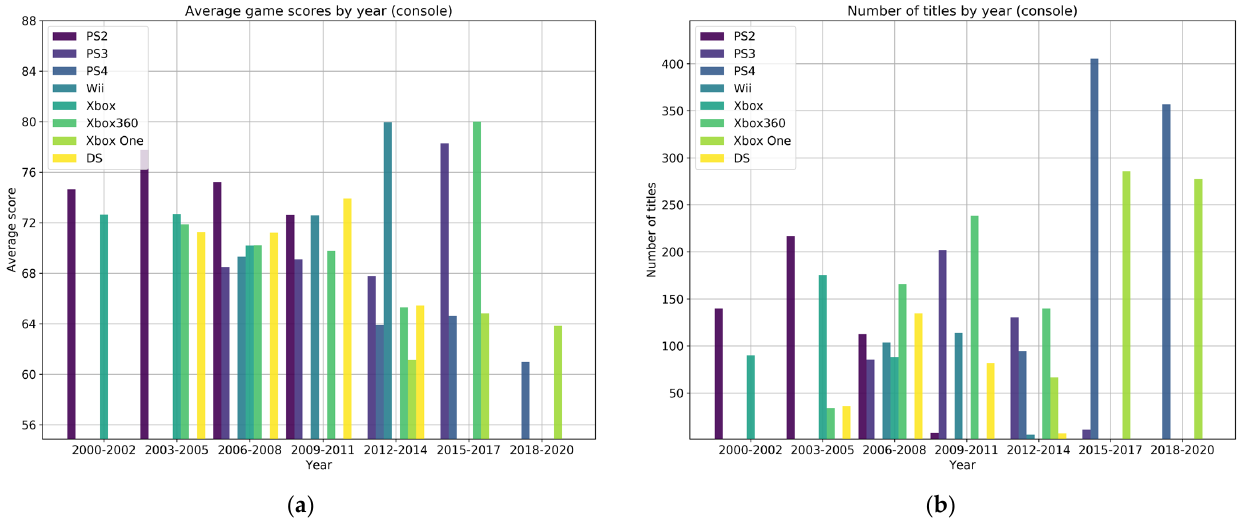
Figure 4. Evaluation of console games statistics over time by console type: ( a ) average user scores by year and console type; ( b ) number of new releases by year and console type.